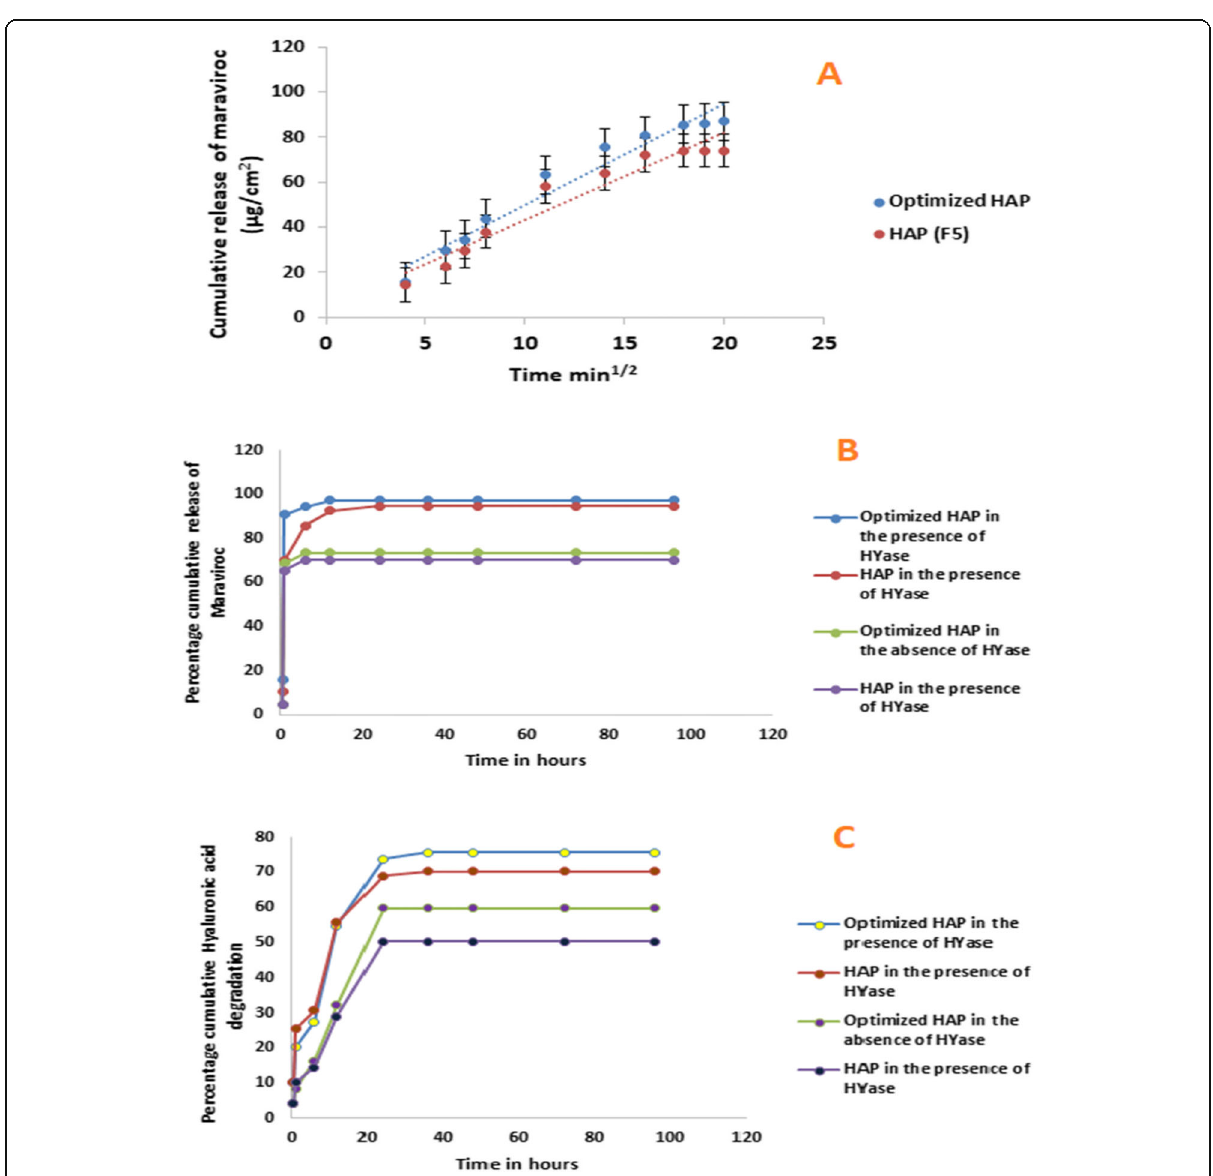
Fig. 4 a In vitro release of maraviroc from the optimized hyaluronic acid-palm oil (HAP)-based organogel and HAP organogel. b Percent cumulative release profile of Maraviroc in presence or absence of HYase and c percent cumulative release profile of hyaluronic acid degradation in presence or absence of HYase carried out at a pH of 7.1 for optimized HAP and HAP organogel